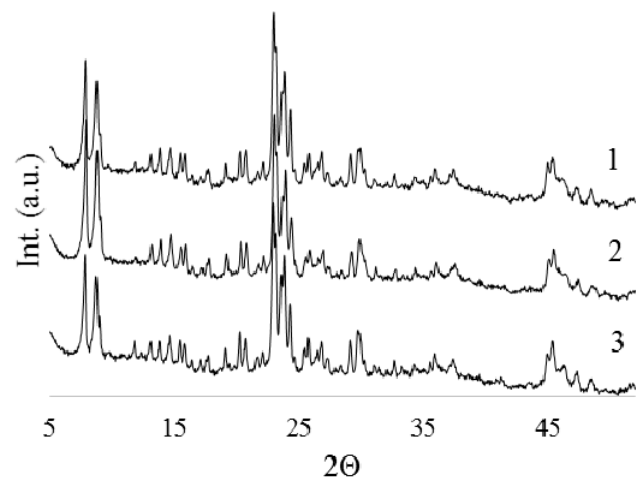
Figure 1. XRD patterns for HZSM-5/Al 2 O 3 , Zr- and Mg-modified samples. 1—HZSM-5/Al 2 O 3 ;